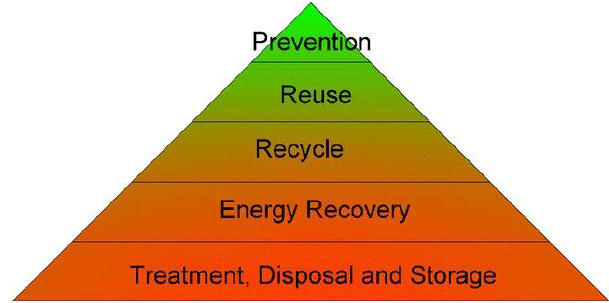
Figure 1. Mine waste hierarchy, adapted from [49].